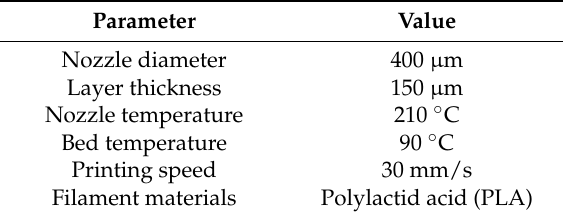
Table 1. Parameters of four-step braiding structure printing.